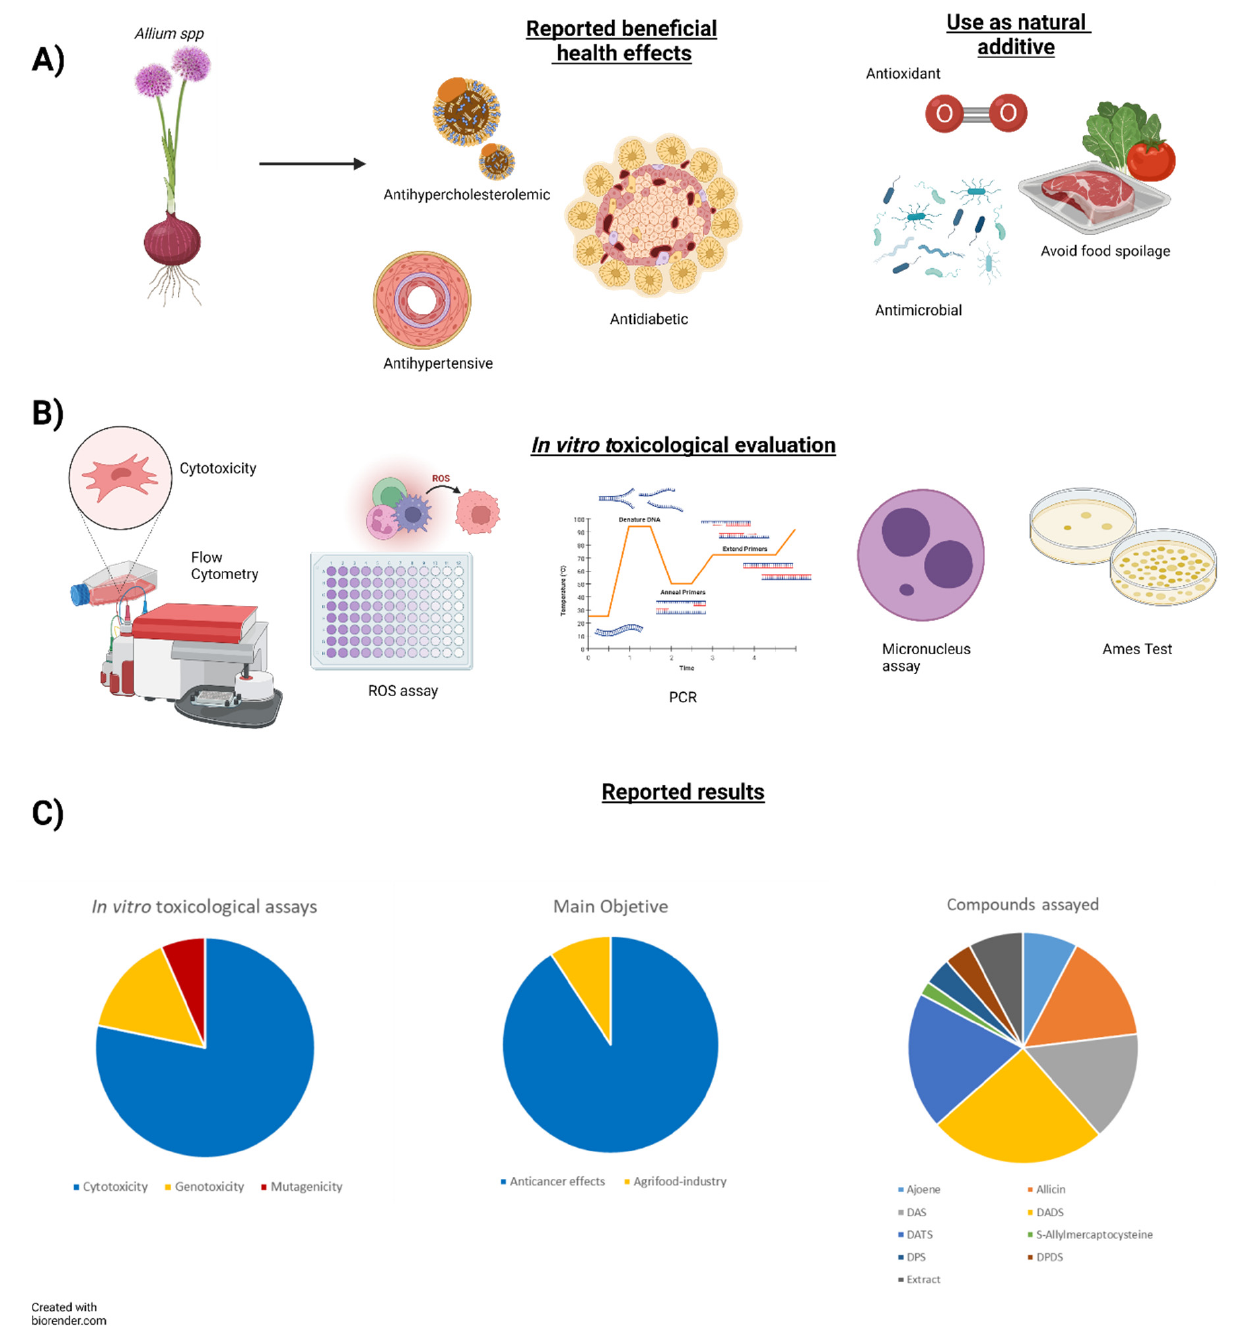
Figure 2. Graphical model: ( A ) reported beneficial health effects, ( B ) in vitro toxicological evaluation and ( C ) reported results.